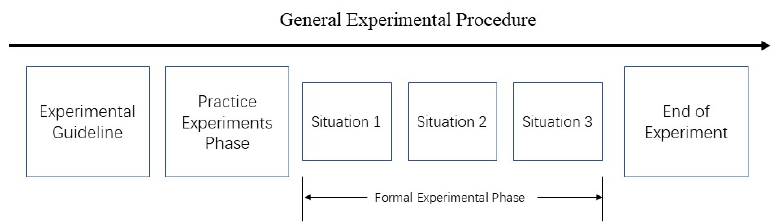
Figure 3. General Experimental